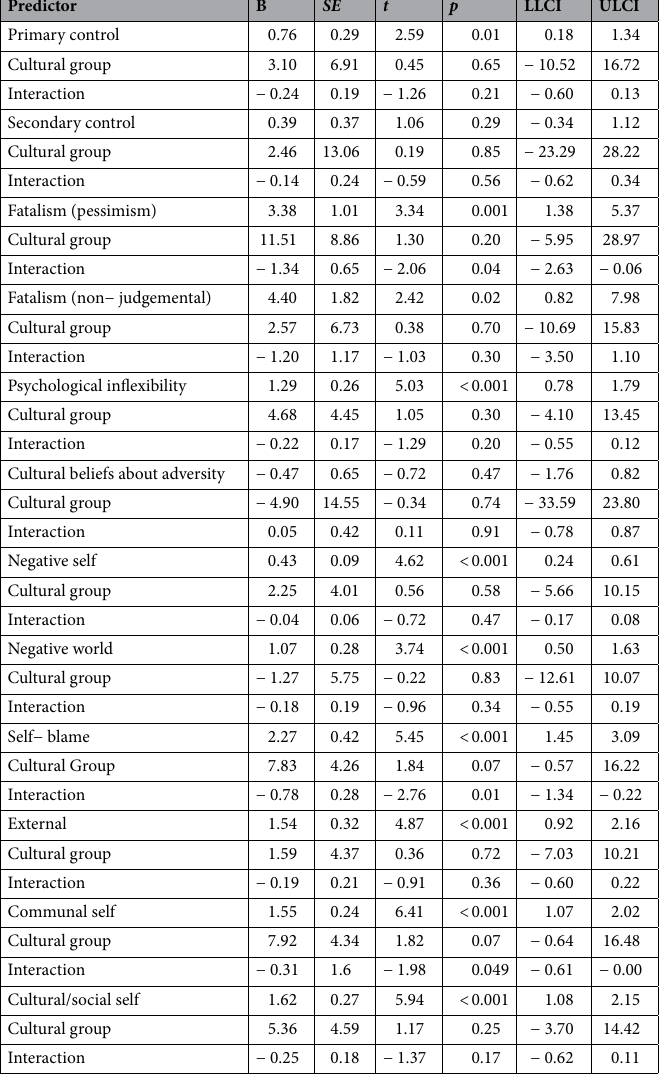
Table 4. Summary of regression analyses for cognitive appraisal analyses with posttraumatic stress disorder symptoms as the outcome variable. LLCI, lower level confidence interval; ULCI, upper level confidence